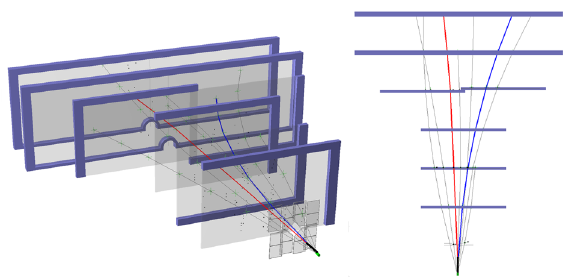
Figure 9. Example of the Λ 0 decay reconstructed in the central tracker in C + C interaction. The red line is a positive track (proton), the blue line is a negative track ( π − ), the black line is a combined track ( Λ 0 ), the green line is a reconstructed vertex. Left) Perspective view of the reconstructed event in the central tracker; Right) Top view of the reconstructed event in the central tracker